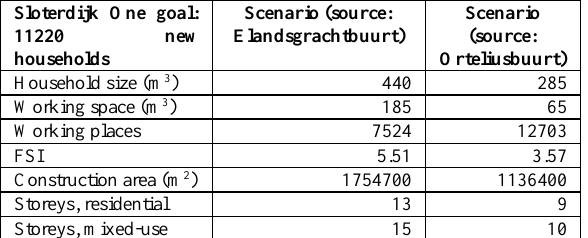
Table 3. Comparison of data extracted from the logs of both scenarios.